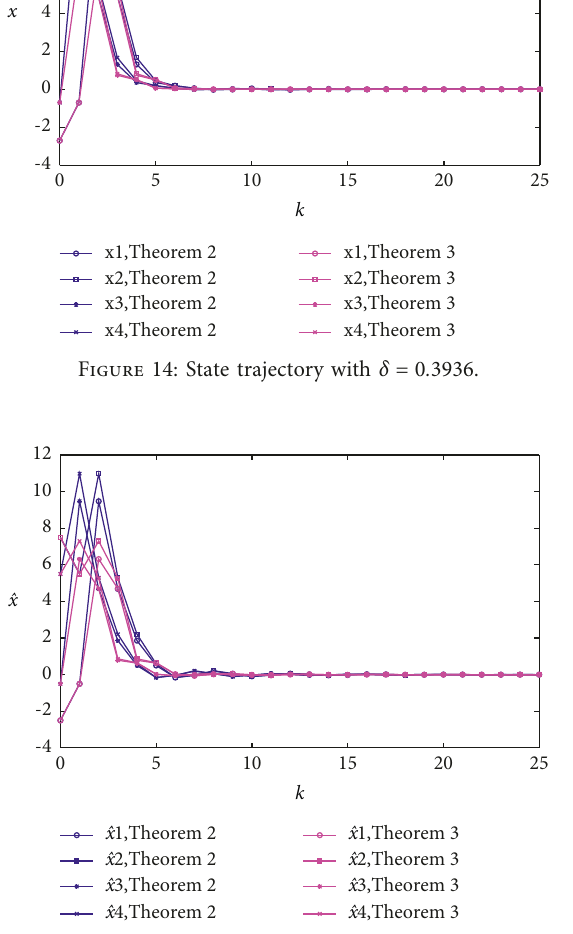
Figure 15: Estimated state trajectory with δ � 0 . 3936.